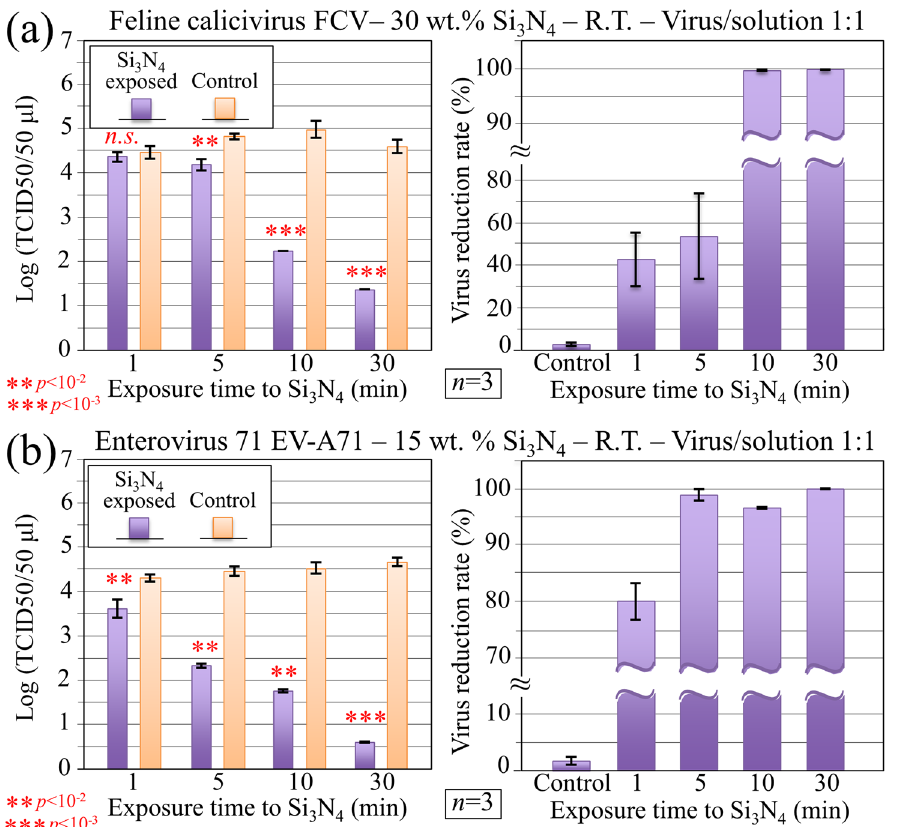
Figure 6. Immunochemistry results collected on: ( a ) CRFK cells infected with FCV virus; and, ( b ) LLC-MK2 cells infected with EV-A71 virus. In both cases, data were collected at room temperature (R.T.) and plotted (with statistical validation) in logarithmic scale as TCID counts and virus reduction rate as a function of virus exposure time to Si 3 N 4 . The fractions of Si 3 N 4 powder contained in the aqueous solution used in virus pre- treatment are given in